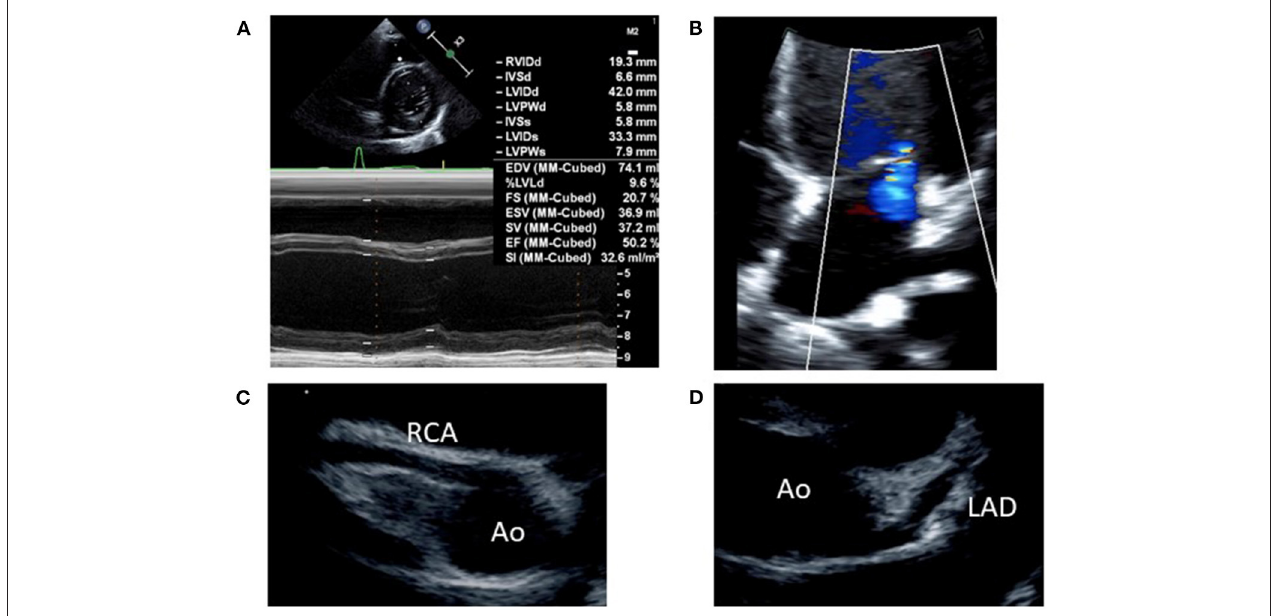
FIGURE 2 | Echocardiography findings on the 6th day of illness: (A) M-mode (left ventricular ejection fraction, 50.2%), (B) mild mitral regurgitation by 4-chamber view, (C) right coronary artery (seg1: 3.0mm, Z score + 1.6), Z score was calculated by “ Z score calculator of coronary arterial diameter” (http://raise.umin.jp/zsp/ calculator/), (D) left coronary artery (seg5: 3.0mm, Z score + 0.9, seg6: 2.7mm, Z score + 1.3, seg11: 2.6mm, Z score + 1.5). Ao, aorta; RCA, right coronary artery; LAD, left anterior descending